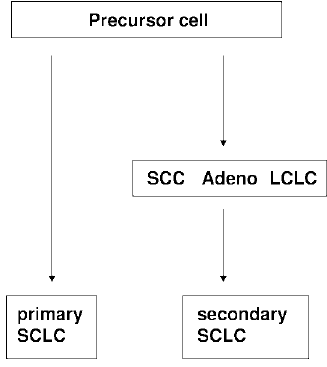
Fig. 3. Model of primary and secondary